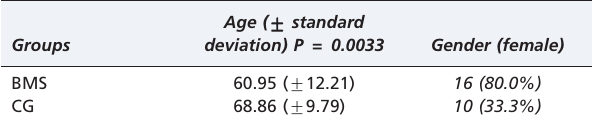
Table 1 - Age and gender of BMS patients and controls (N = 50).